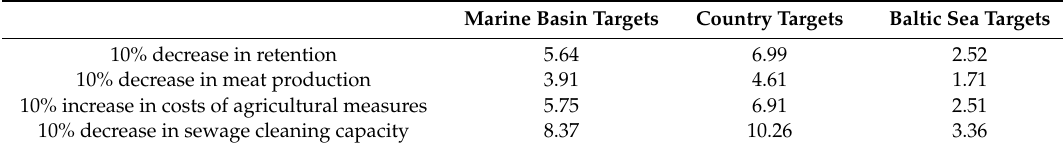
Table 3. Costs for achieving alternative targets under di ff erent scenarios, billion